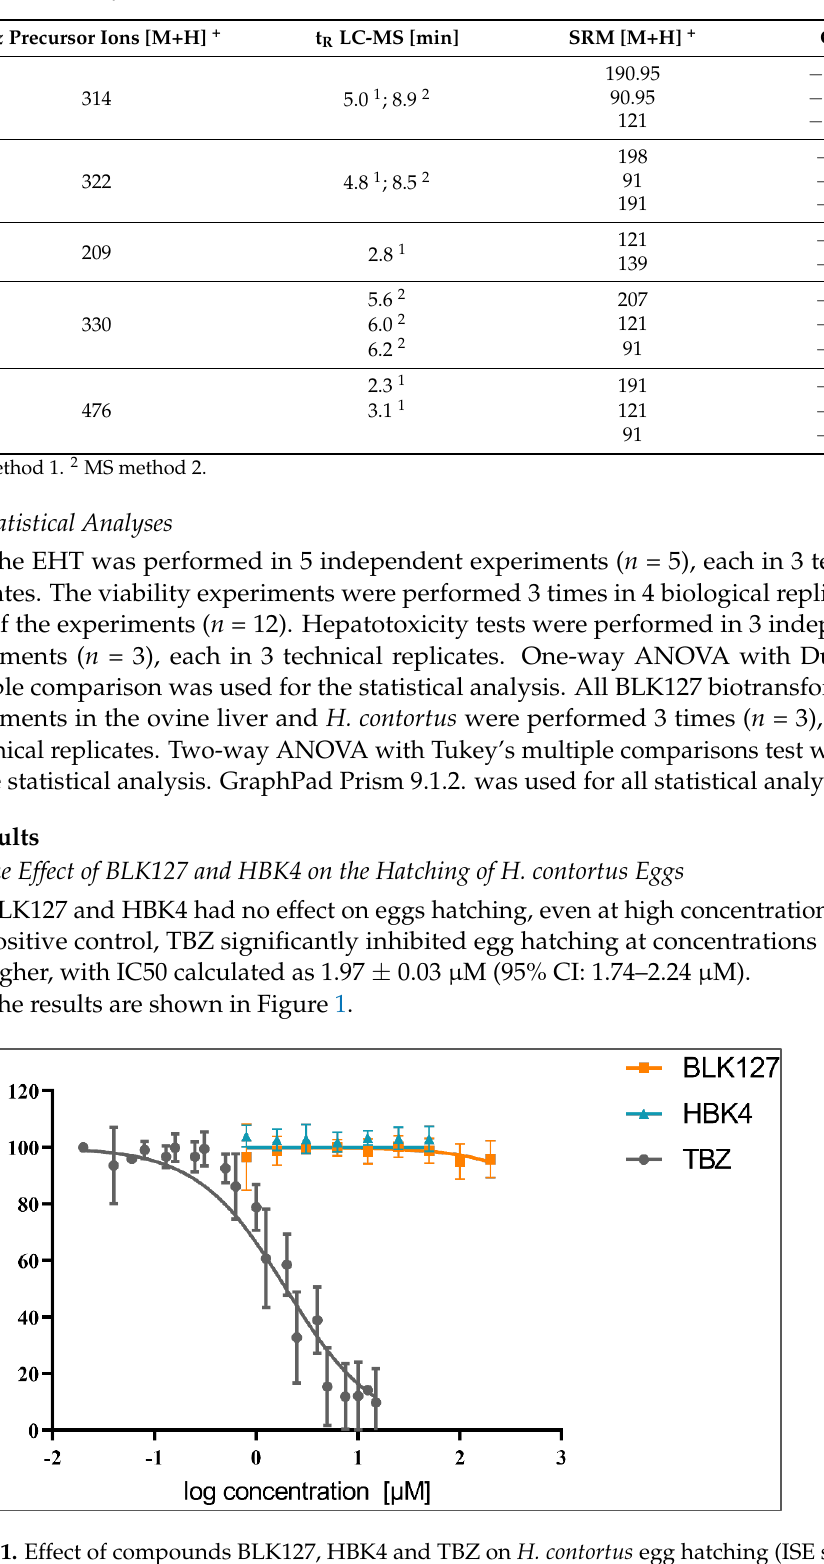
Table 1. List of the m / z of precursor ions, retention times (t R ), selected reaction monitoring (SRM), and collision energy (CE) for BLK127, internal standard and its main metabolites in H. contortus adults measured by LC-MS.